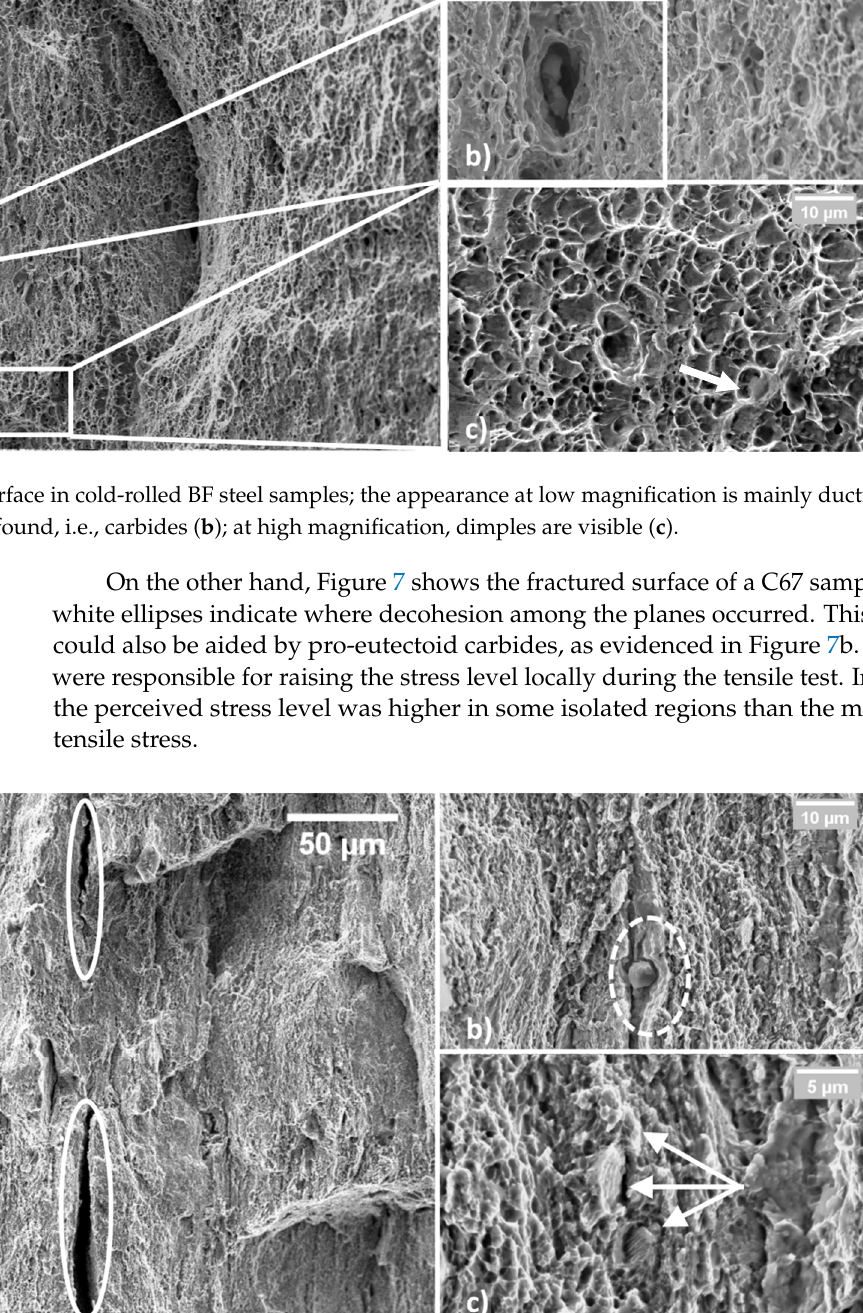
Figure 7. Fractured surface of tensile C67 sample; large areas appear as delaminated ( a ); secondary phases, such as pro- euctectoidic carbides were found ( b ); far away from delaminated areas, the fracture is ductile, and perlite grains are still visible ( c ).